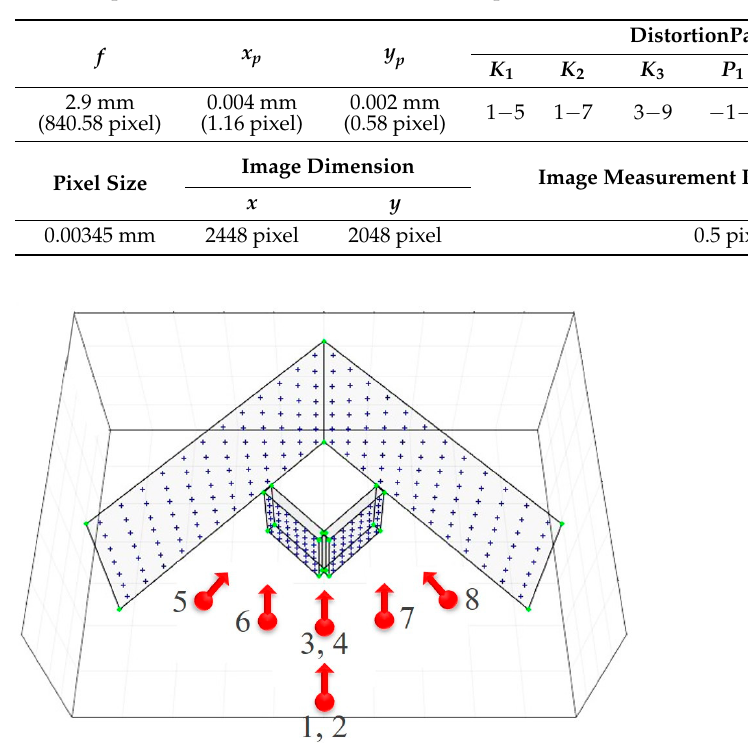
Table 1. Specification of camera in simulation experiments.